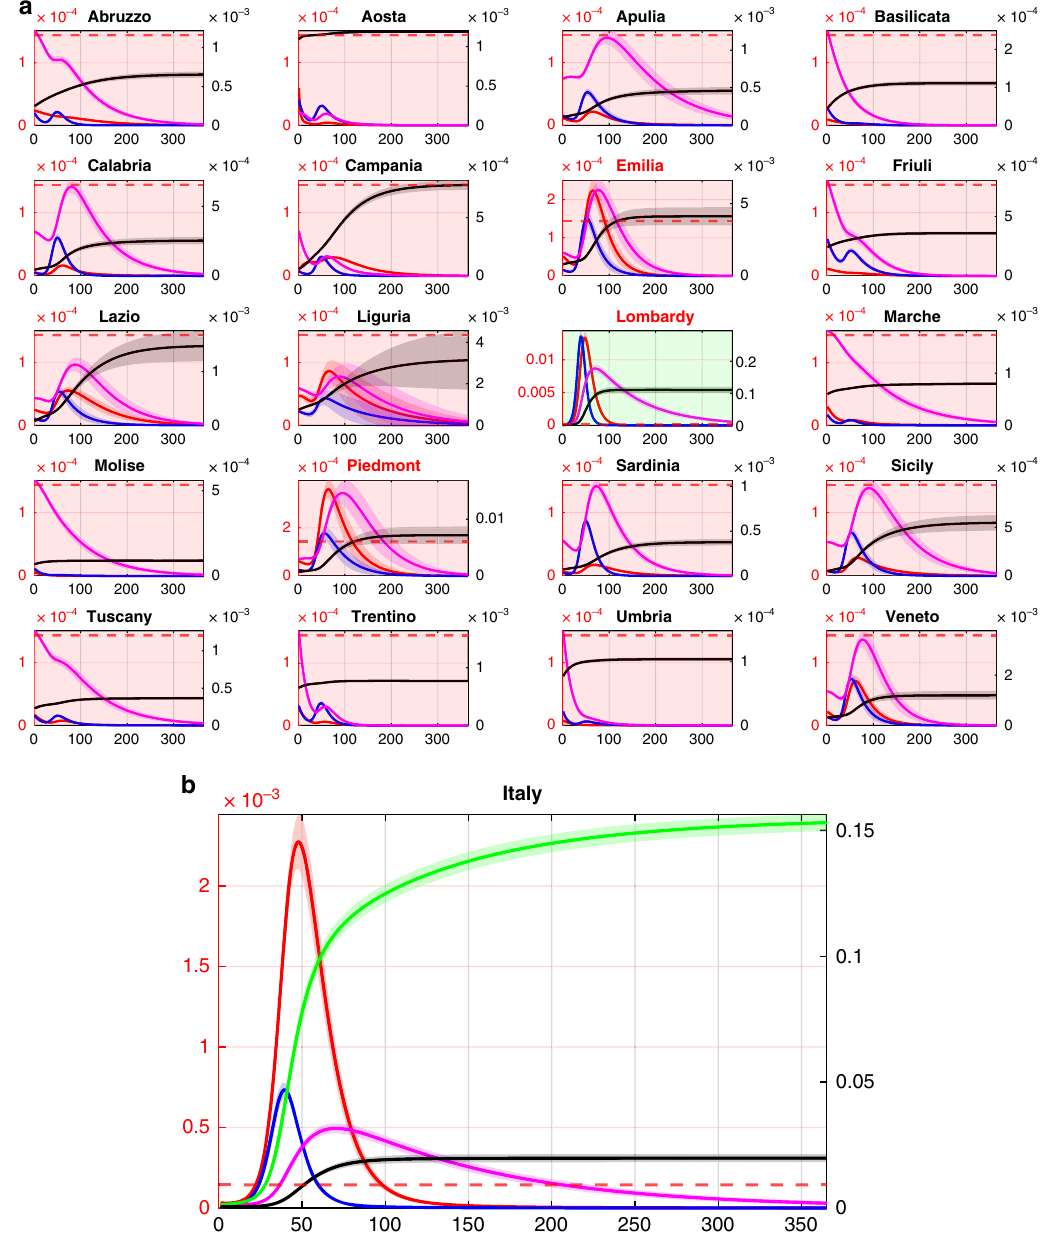
Fig. 2 Only one region relaxes its lockdown. Double scale plots of the a regional and b national dynamics in the case where only one region (Lombardy in Northern Italy) relaxes its containment measures at time 0, while inter-regional fl uxes are set to the level they reached during the lockdown. (Regional dynamics when the fl uxes between regions are set to their prelockdown level are shown in Supplementary Fig. 1 showing even more dramatic scenarios.) The scale on the left vertical axis (in red) applies to the fraction of hospitalized requiring ICU (red solid line) and the ICU beds capacity threshold ( T H i = N i , dashed red line). The scale on the right vertical axis (in black) applies to the infected (blue), quarantined (magenta), recovered (green) and deceased (black). The time scale, on the horizontal axis, is given in days. Panels of regions adopting a lockdown are shaded in red while those of regions relaxing social containment measures are shaded in green. Results are averaged over 10,000 simulations with parameters sampled using a Latin Hypercube technique (see Methods) around their nominal values set as those estimated in the last time window for each region as reported in Supplementary Table 4. Shaded bands correspond to twice the standard deviation. The regions identi fi ed with a red label are those where the total hospital capacity is